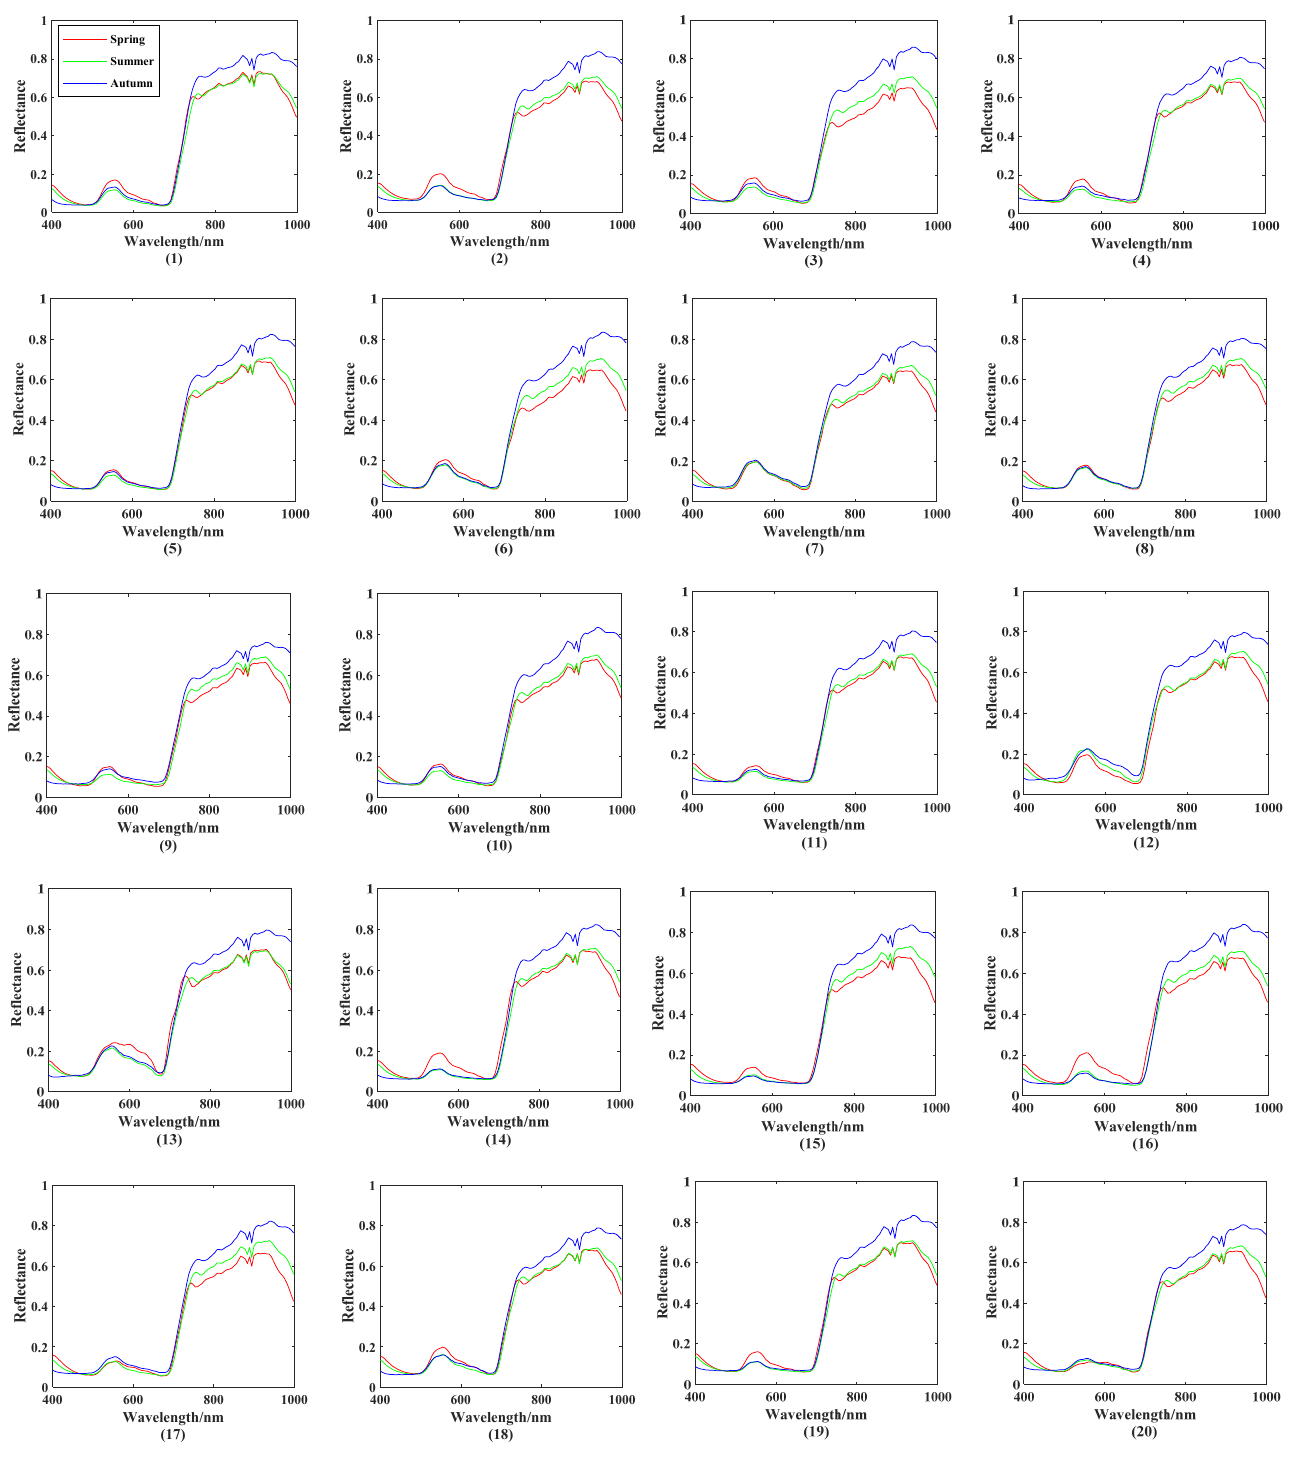
Figure 9. Average reflectance spectra of leaves for each tree species in different seasons. ( 1 ) Ilex chinensis Sims , ( 2 ) Lonicera maackii , ( 3 ) Sophora japonica , ( 4 ) Amygdalus triloba , ( 5 ) Syringa oblata Lindl. , ( 6 ) Kerria japonica , ( 7 ) Rhodotypos scandens , ( 8 ) Weigela florida , ( 9 ) Acer grosseri Pax , ( 10 ) Viburnum opulus Linn. , ( 11 ) Cerasus serrulate , ( 12 ) Philadelphus pekinensis Rupr. , ( 13 ) Chaenomeles speciosa , ( 14 ) Malus micromalus , ( 15 ) Syringa pubescens , ( 16 ) Ligustrum quihoui Carr. , ( 17 ) Rosa chinensis Jacq. , ( 18 ) Swida alba Opiz , ( 19 ) Forsythia suspensa , and ( 20 ) Prunus Cerasifera